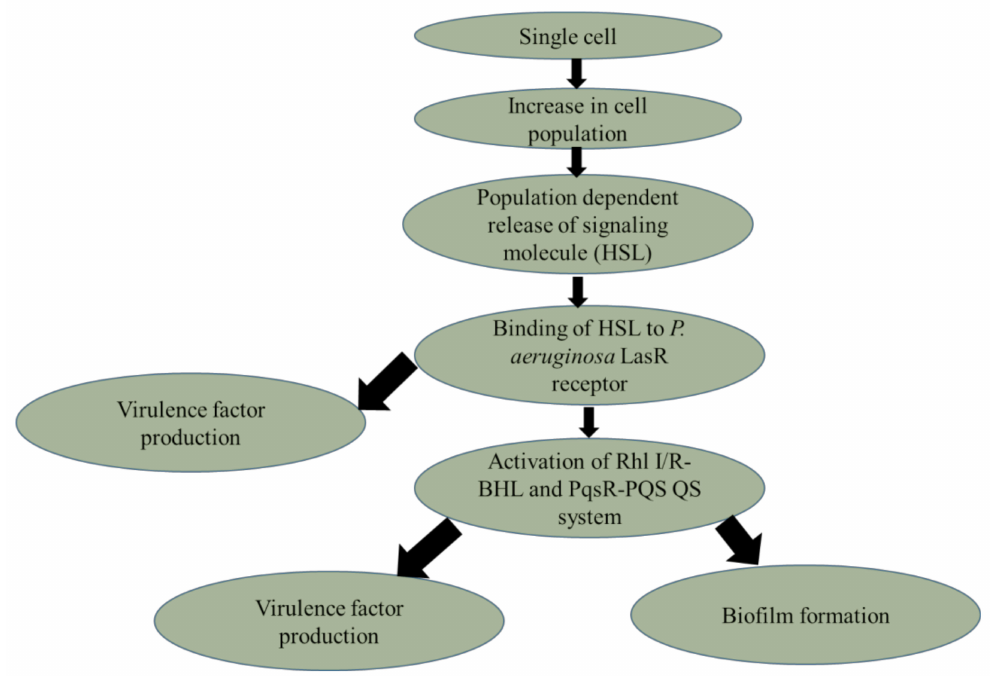
Figure 7. Schematic showing how P. aeruginosa QS systems result in virulence factor production and biofilm formation. Binding of AHL/HSL to LasR triggers transcription of Rhl I/R and PqsR and the production of their ligands BHL and PQS. These QS systems then coordinated the biosynthesis of virulence factors such as pyocyanin and the formation of